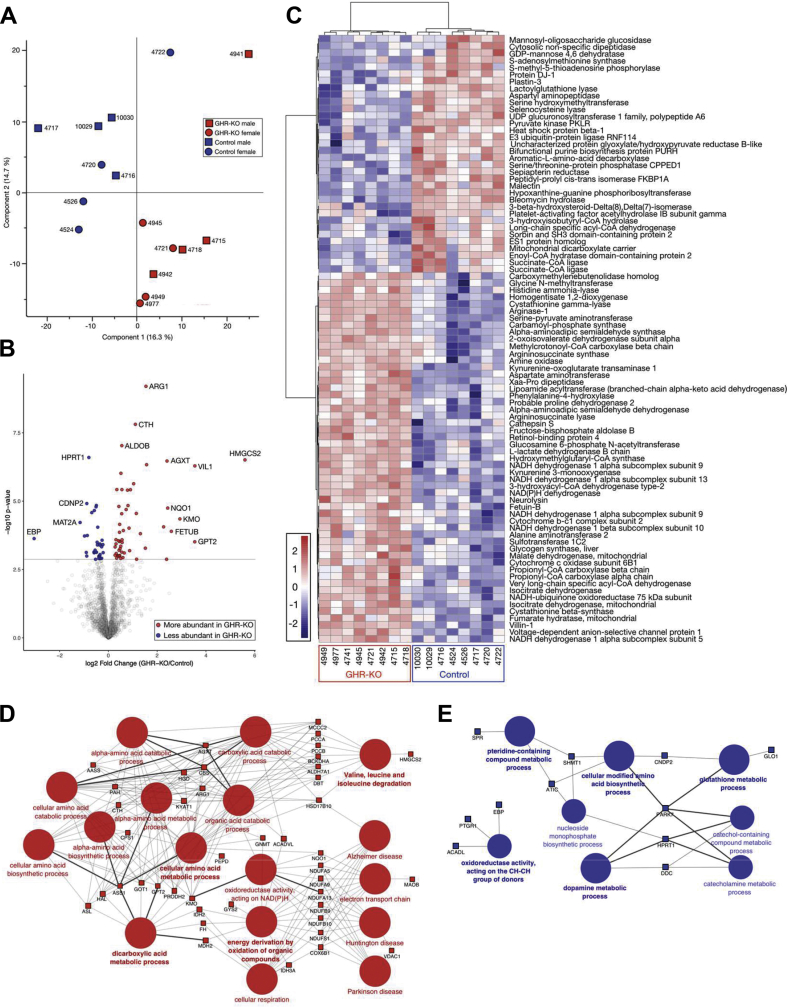
Proteome differences between liver samples from GHR-KO and control pigs. A: Principal component analysis (PCA) clearly separates proteomes from GHR-KO and control samples. B: Volcano plot of log2 fold changes (GHR-KO/control). Differentially abundant proteins (p < 0.05) are highlighted. C: Heat map of the differentially abundant proteins. D, E: ClueGO functional enrichment analysis for proteins significantly increased (D) or decreased (E) in abundance in GHR-KO vs. control liver samples. The analysis used the term GO Biological Process and KEGG pathways (min. 8 genes/cluster in D and min. 3 genes/cluster in E). The size of the circles indicates the significance of enrichment.